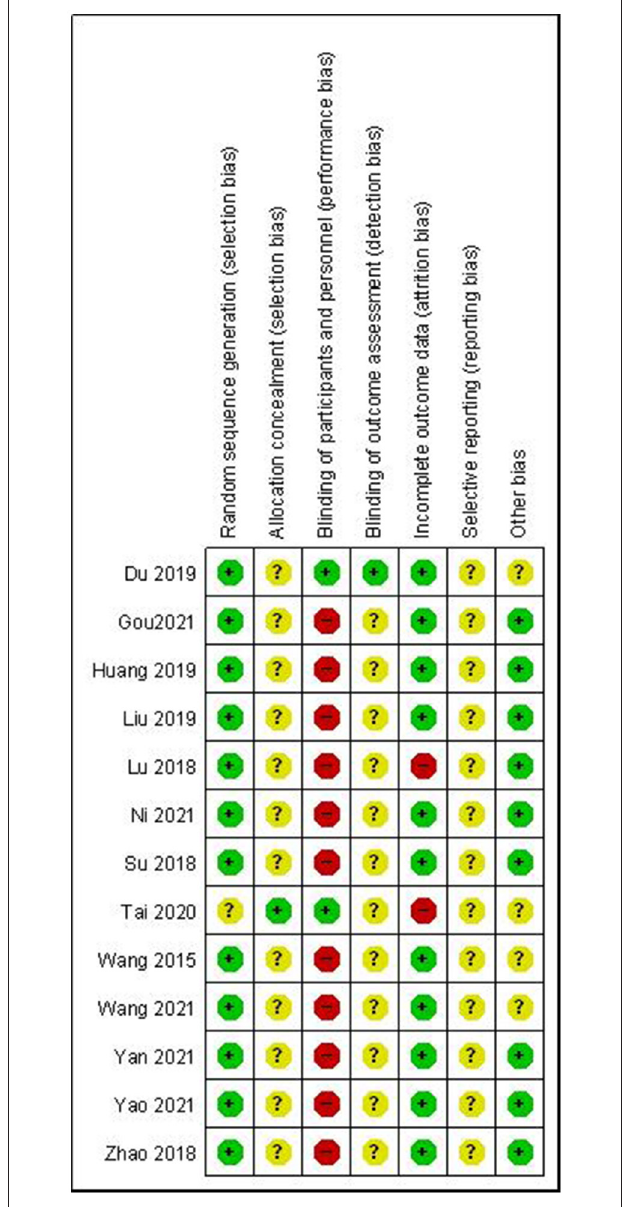
FIGURE 2 | Risk of bias assessment using the Cochrane tool.